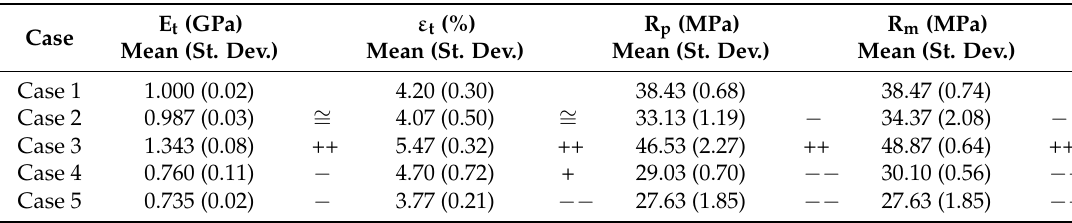
Table 6. The mechanical properties of PLA test specimens and the variation with respect to the benchmark case (Case 1).